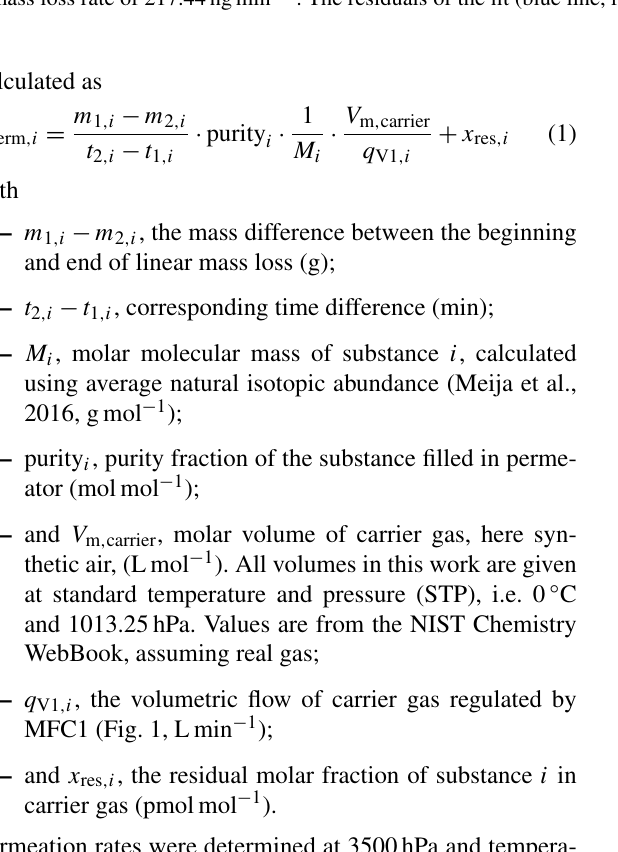
Figure 2. Example of measured mass loss rate for CFC-13 with magnetic suspension balance Violetta. After stabilisation of the permeation rate (first 6000min), the mass loss becomes linear – the measured mass loss (6000 to 12000min) can be fitted to a linear function, yielding a mass loss rate of 217.44ngmin − 1 . The residuals of the fit (blue line, right axis) are centred around zero and randomly